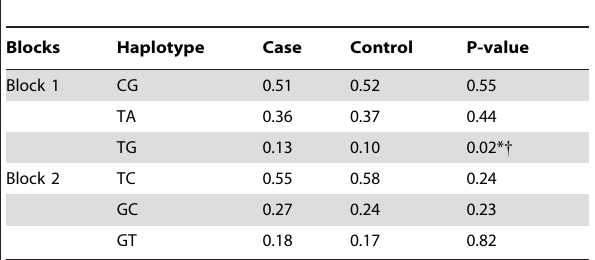
Table 3. Association between CYP4F3 haplotypes and CD.